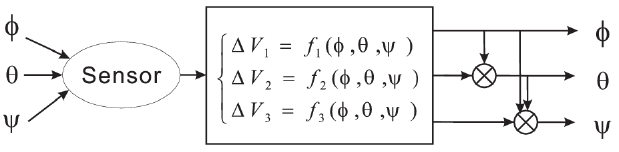
Figure 8. Process of three parameters